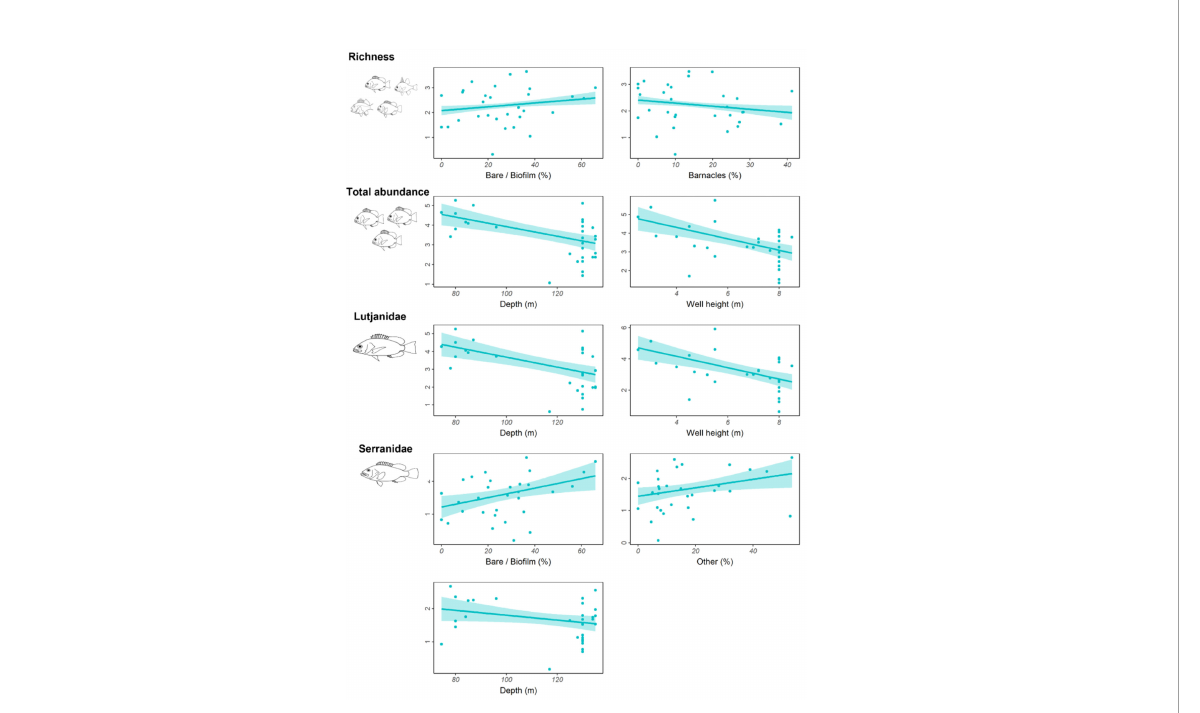
FIGURE 5 Total residual abundance of fi shery target species, richness and residual abundance of the two most abundant fi shery target families on wells in <150 m depth in the north-west. Residual abundances are plotted relative to their most important explanatory variables (Table 4; Figure S2). Models were fi tted using Generalised additive models. The solid line represents the estimated smoothing curve, and dashed lines represent ±2 × south-east of the